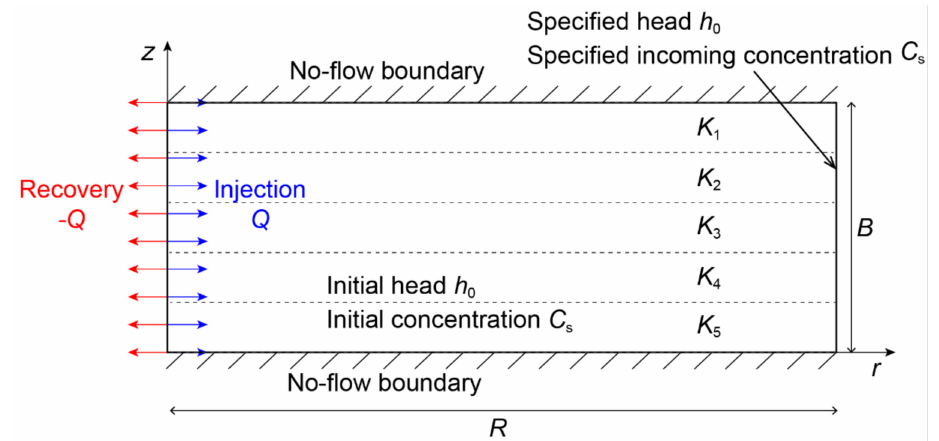
Figure 1. Conceptual model of 2D axisymmetric flow and transport associated with ASR imple- mented in a confined five-layer